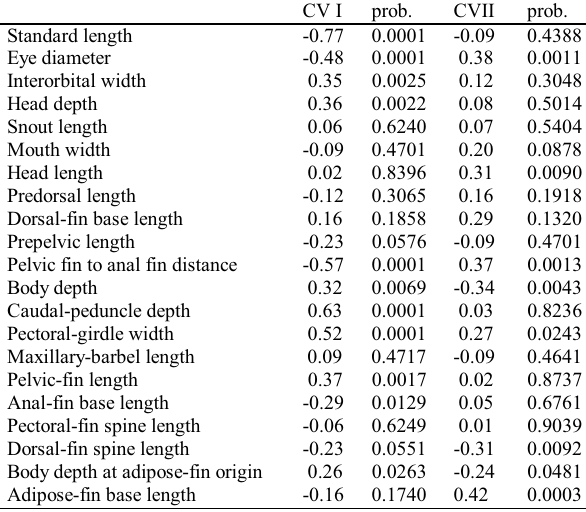
Table 2. Loadings of variables in the first and second size- free Canonical Variates of Microglanis garavelloi (rio Pirapitingui, rio Capibara, and rio Taquari), M. parahybae (rio Dois Rios, and rio Muriaé), and M. cottoides (Sanga das Águas Frias).